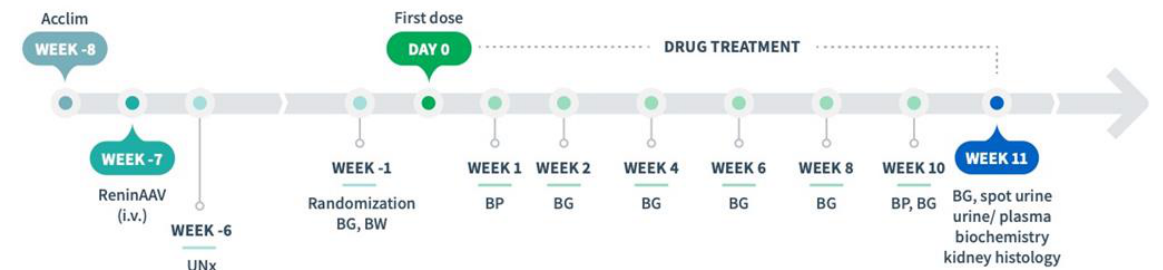
Figure 1. Study outline. db / db UNx-ReninAAV mice were treated (q.d.) with vehicle (s.c.), semaglutide (30 nmol/kg, s.c., or combination treatment with semaglutide (30 nmol/kg, s.c.) + lisinopril (30 mg/kg, p.o.) for 11 weeks. Abbreviations: AAV, adeno-associated virus; Acclim., acclimatization; BG, blood glucose; BP, blood pressure; BW, body weight; i.v., intravenous; UNx, uninephrectomy.